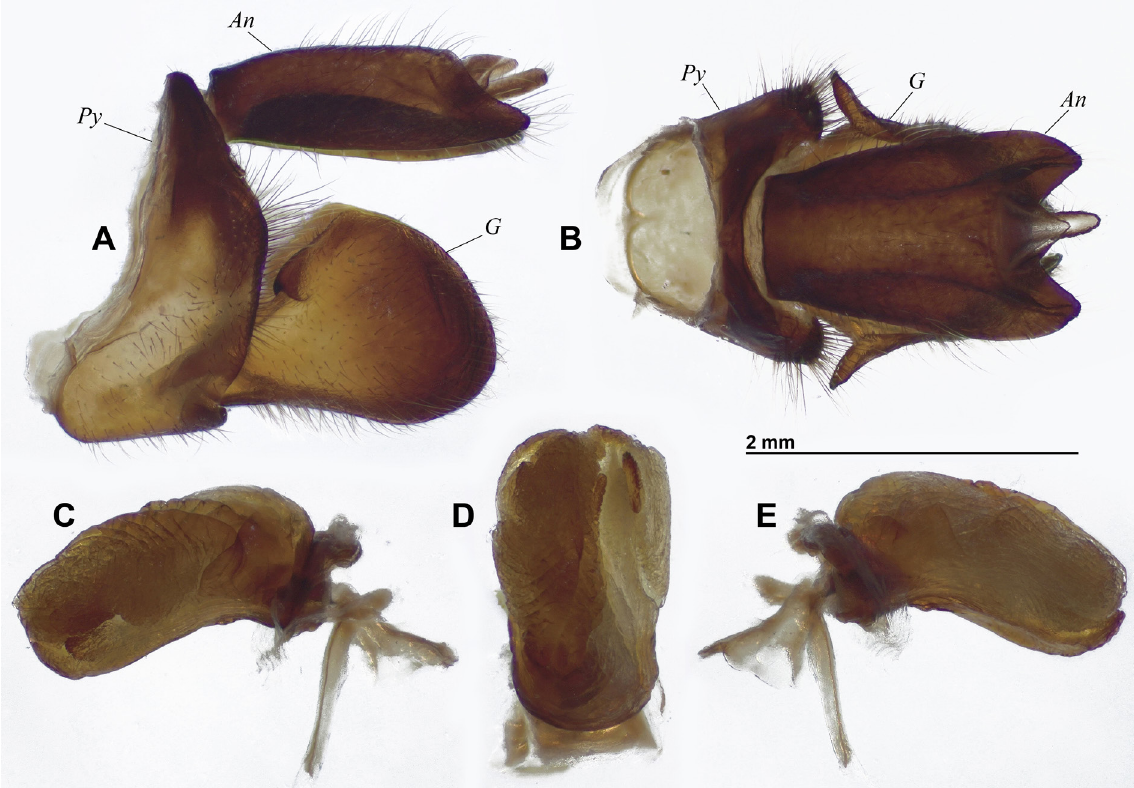
Fig. 9. Birdantis trilineata (Schmidt, 1926), ♂, genitalia. A . Pygofer, anal tube and gonostyli, left lateral view. B . Pygofer, anal tube and gonostyli, dorsal view. C . Aedeagus, right lateral view. D . Aedeagus, dorsal view. E . Aedeagus, left lateral view. Abbreviations: An = anal tube; G = gonostyli; Py =